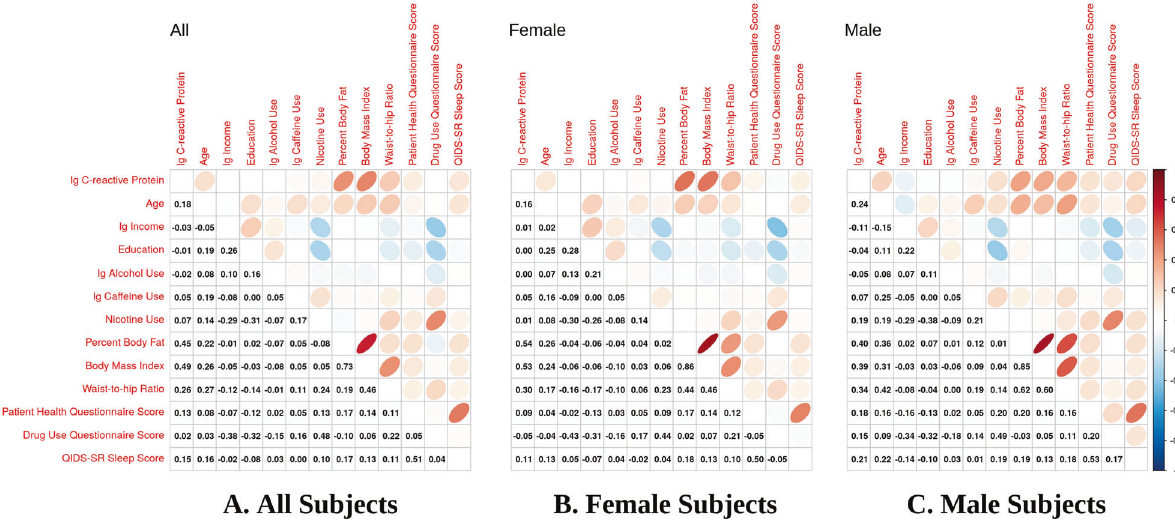
Fig. 1 Pearson correlation coef fi cient plots for CRP and covariates. The plots show the Pearson correlation coef fi cients for A the combined male and female sample (All), B female-only sample, and C male-only sample. The ellipses are the visualizations for the corresponding Pearson correlation coef fi cients. Positive correlation is displayed in blue with slope of 1 and negative correlation is in red color with slope of − 1. The color intensity and the eccentricity of the ellipse are proportional to the absolute value of correlation coef fi cient. For Pearson correlation coef fi cients of 0.1 or greater, CRP was positively correlated for A All subjects with age ( r = 0.18), caffeine use ( r = 0.05), nicotine use ( r = 0.07), body mass index (BMI) ( r = 0.49), percent body fat (PBF) ( r = 0.45), waist-to-hip ratio (WHR) ( r = 0.26), PHQ score ( r = 0.13), and QIDS-SR Sleep score ( r = 0.15); B Female subjects with age ( r = 0.16), caffeine use ( r = 0.05), BMI ( r = 0.53), PBF ( r = 0.54), and WHR ( r = 0.30), PHQ ( r = 0.09), and QIDS-SR ( r = 0.11); and C Male subjects with age ( r = 0.24), caffeine use ( r = 0.07), nicotine use ( r = 0.19), BMI ( r = 0.39), PBF ( r = 0.40),